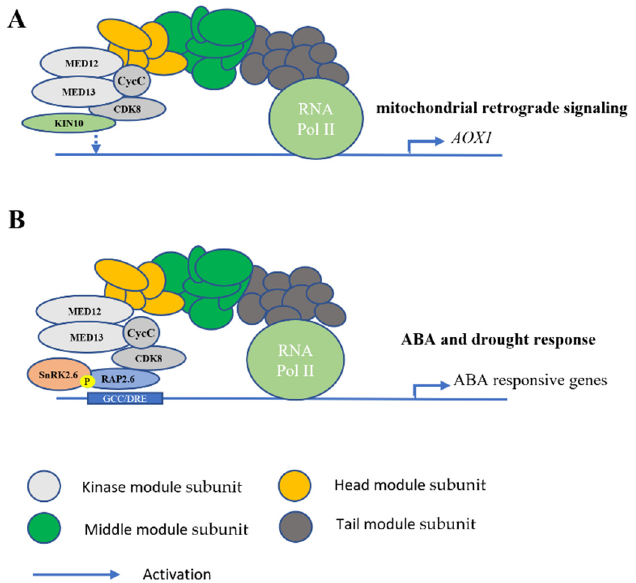
Figure 3. The regulatory functions of CDK8 subunit in abiotic stress response. ( A ) CDK8 cooperates with KIN10 to control the expression of AOX1 to regulate mitochondrial retrograde signaling. ( B ) CDK8 along with phosphorylated proteins of RAP2.6 and SnRK2.6 bind to the GCC/DRE-box to initiate the transcription of ABA responsive genes in response to ABA and drought stress. Light gray indicates the CDK8 kinase module, yellow indicates the head module, green indicates the middle module and dark gray indicates the tail module.